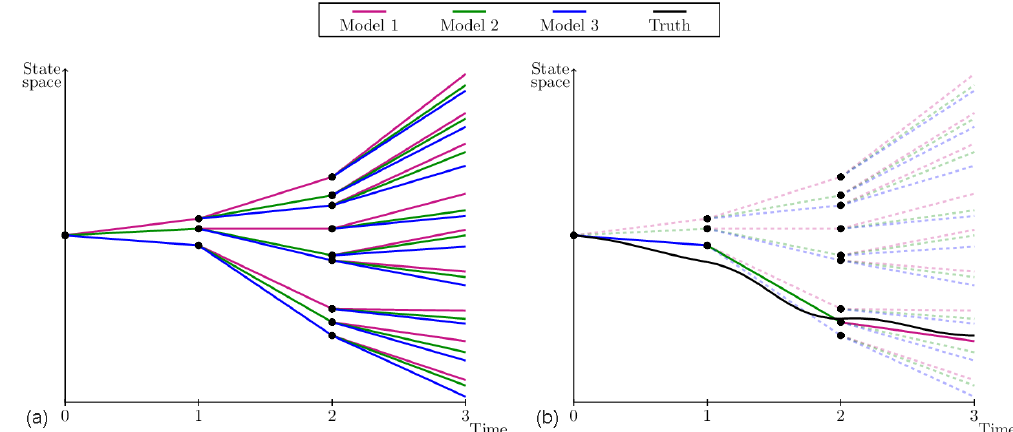
Figure 3. Adapted from Schevenhoven and Selten (2017). A one-dimensional schematic of CPT for three models, a full ensemble (a) and a pruned ensemble (b) . Note that the “truth” has been drawn here as a continuous line for illustrative purpose. In practice, the truth is only known at discrete times (the observation times) and the distance with respect to model trajectories is computed at those times only.